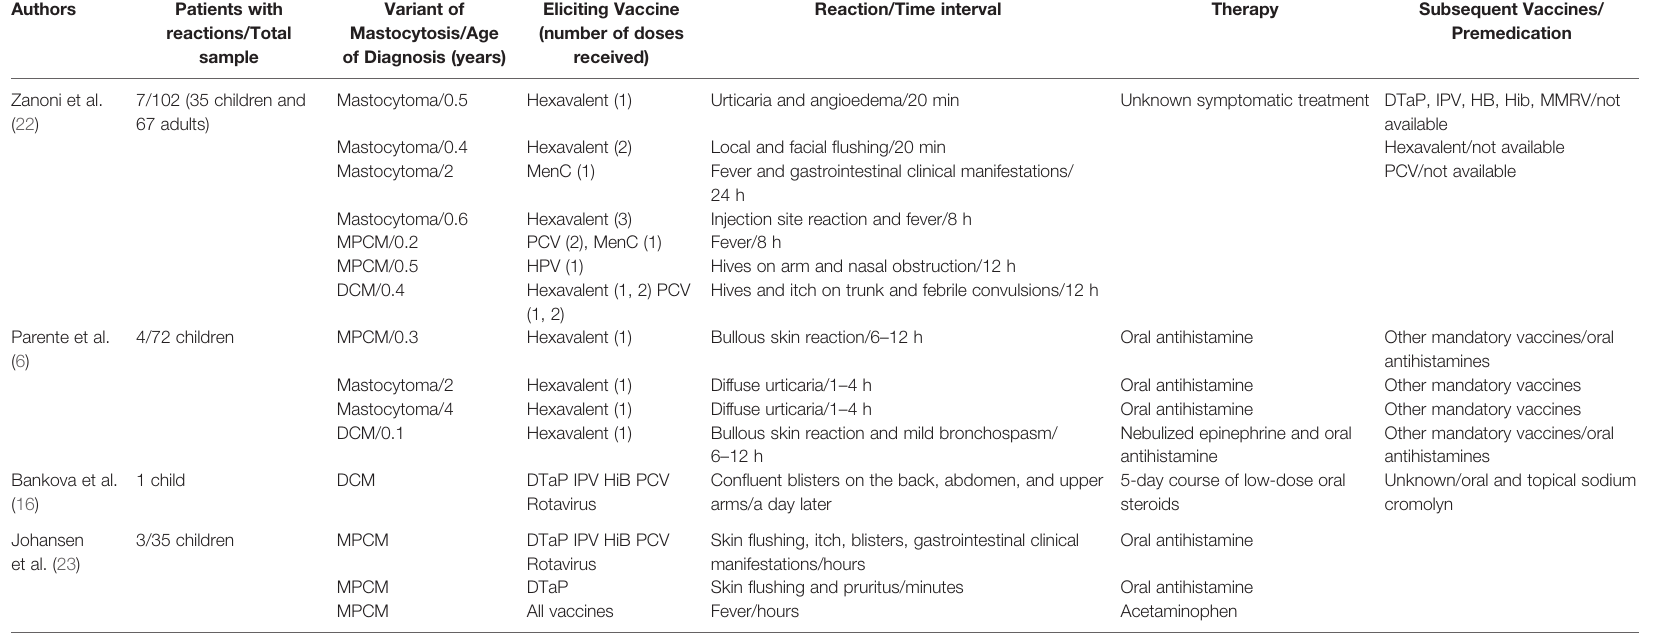
TABLE 2 | Clinical data about patients from the analyzed studies on vaccination and